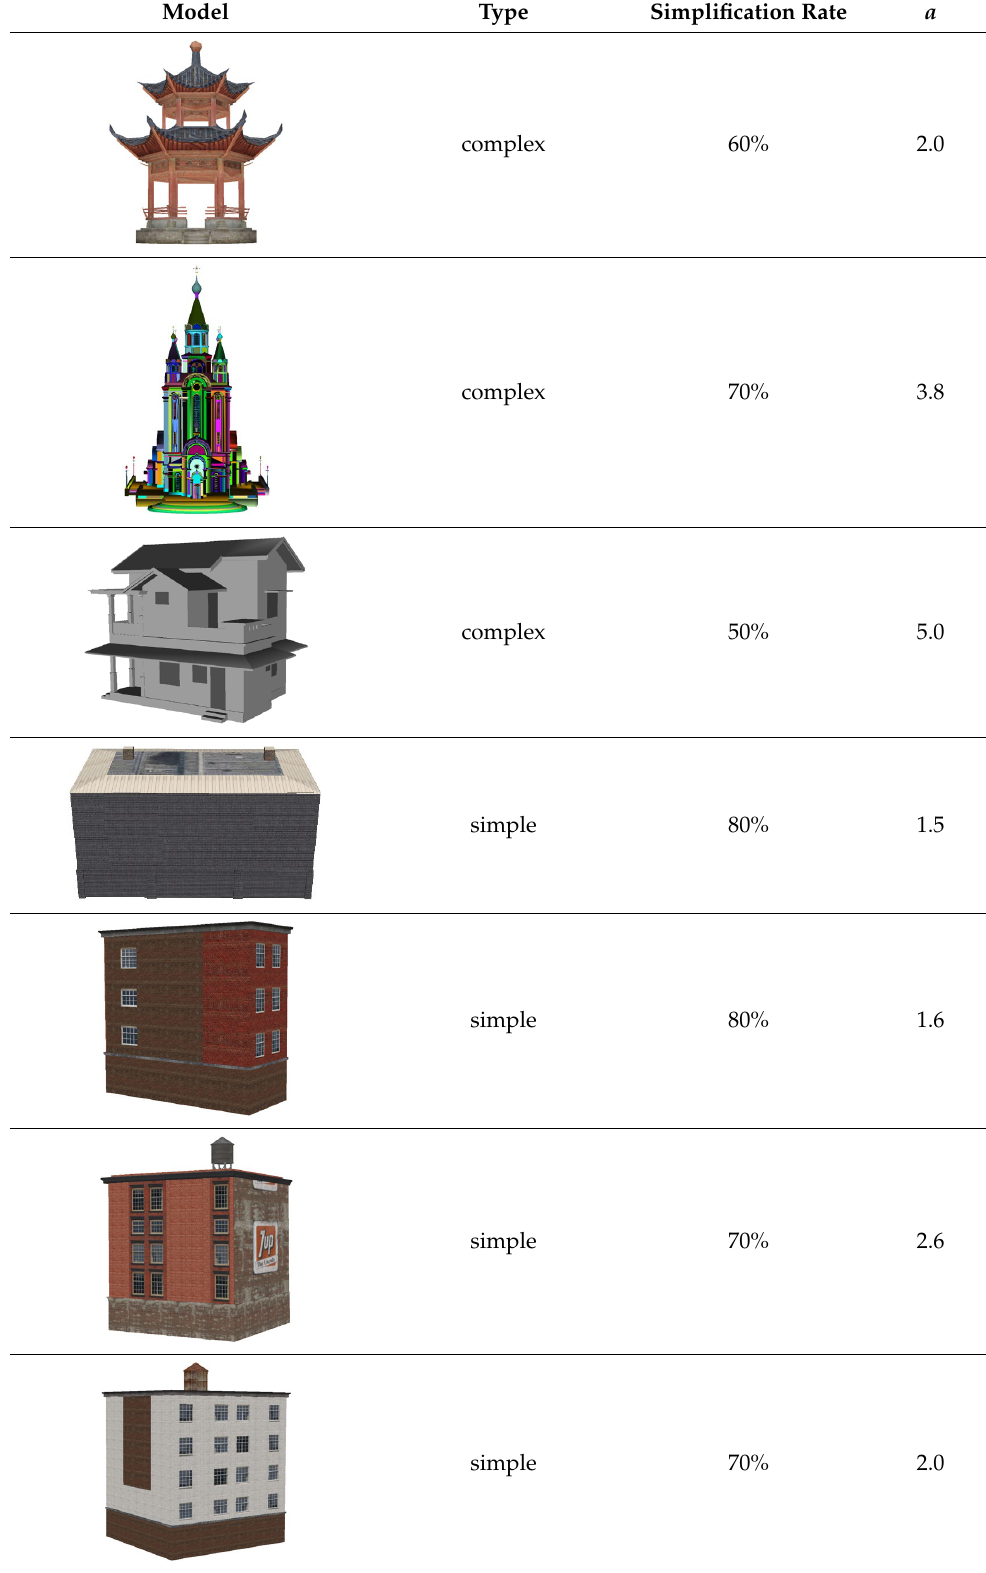
Table 2. The detailed model information for parameter analysis.